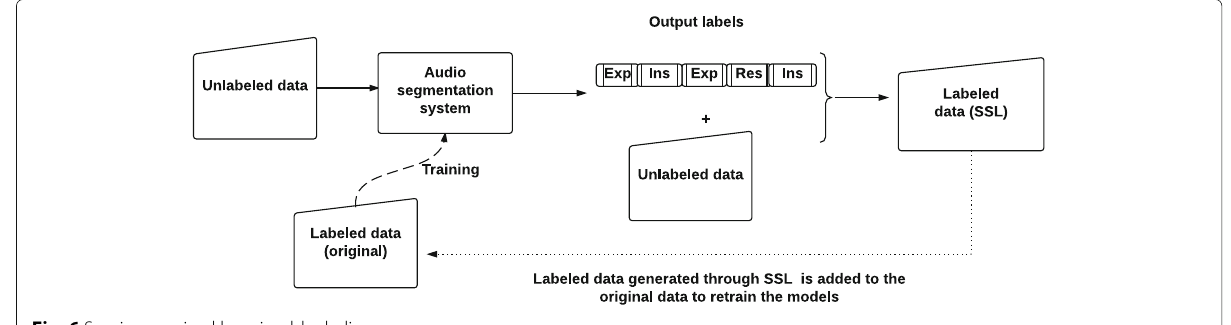
Fig. 6 Semi-supervised learning block diagram